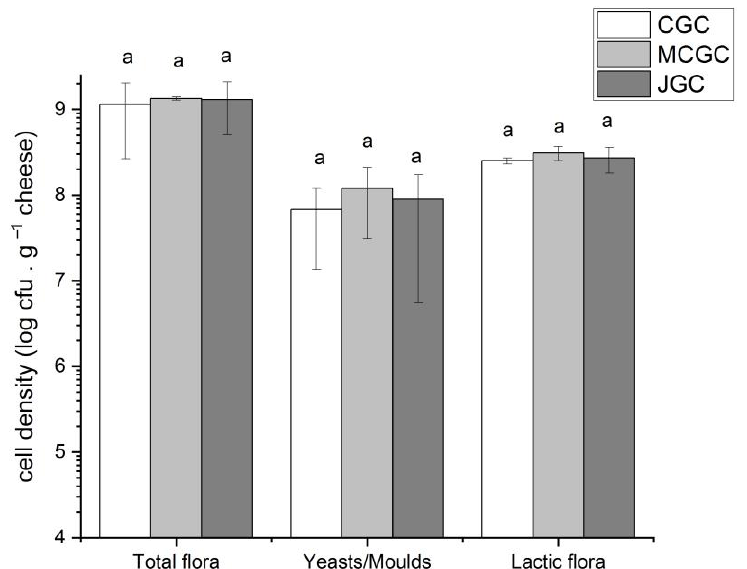
Figure 1. Microbiological counts (cfu/g of cheese) of different microbial groups found in goat cheeses unflavored and flavored with Gentiana lutea rhizomes from Massif Central and Jura. Error bars represent the standard deviation of the three biological triplicates. The letter a indicates there is no difference ( p > 0.05) among cheeses per type of analyzed flora.